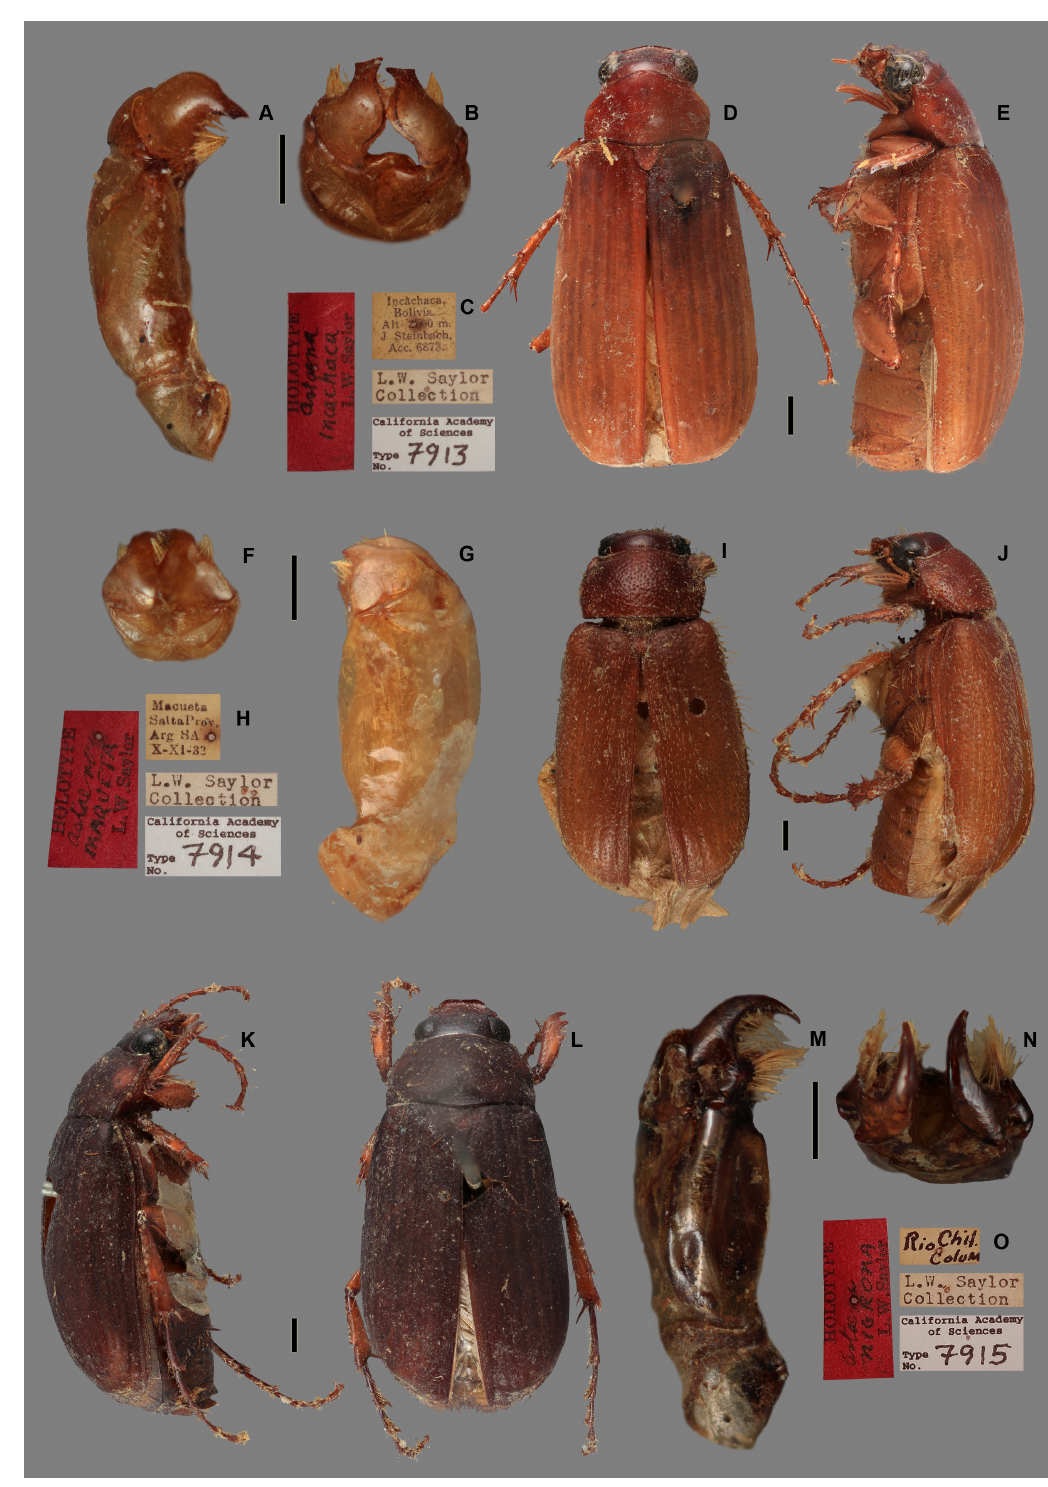
Fig. 3. A–E . Astaena incachaca Saylor, 1946, holotype, ♂ (Type No. 7913; CAS). – F–J . A. maqueta Saylor, 1947, holotype, ♂ (Type No. 7914; CAS). – K–O . A. nigrona Saylor, 1947, holotype, ♂ (Type No. 7915; CAS). A, G, M . Aedeagus, lateral view. B, F, N . Parameres, dorsal view. C, H, O . labels. D, I, L . Habitus, dorsal view. E, J, K . Habitus, lateral view. Scale bars: A–B, F–G, M–N = 0.5 mm; D–E, I–L = 1